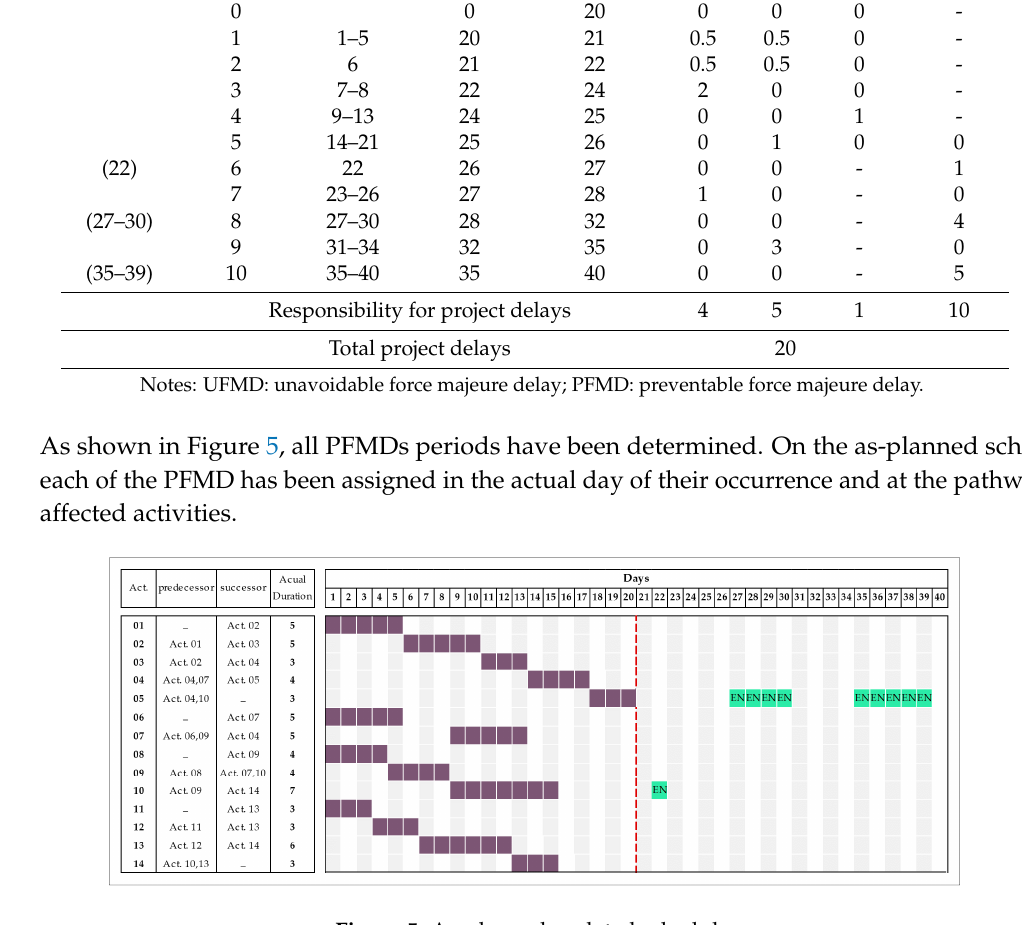
Table 2. The results for classifying the project delays.